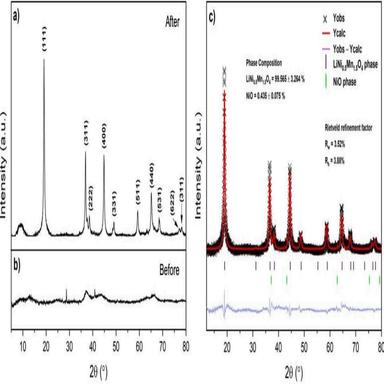
(a–b) XRD patterns of LNMO prepared before and after the hydrothermal reaction and c) The Rietveld refinement results of LNMO.